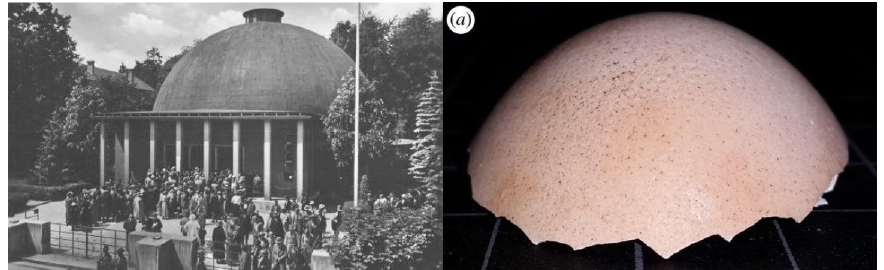
Figure 3. Left : Zeiss Planetarium in Jena, Germany, by Franz Dischinguer, 1926, (picture by Karl Müller, 1926). Right : intact egg cap resulting from distributed load experiment